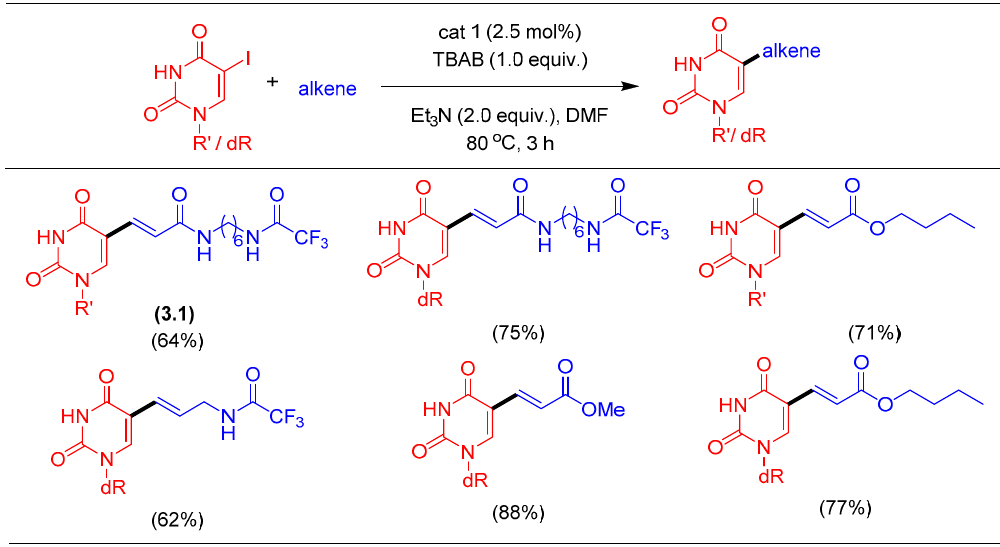
Scheme 1. Pd-catalyzed Heck alkenylation of uracil